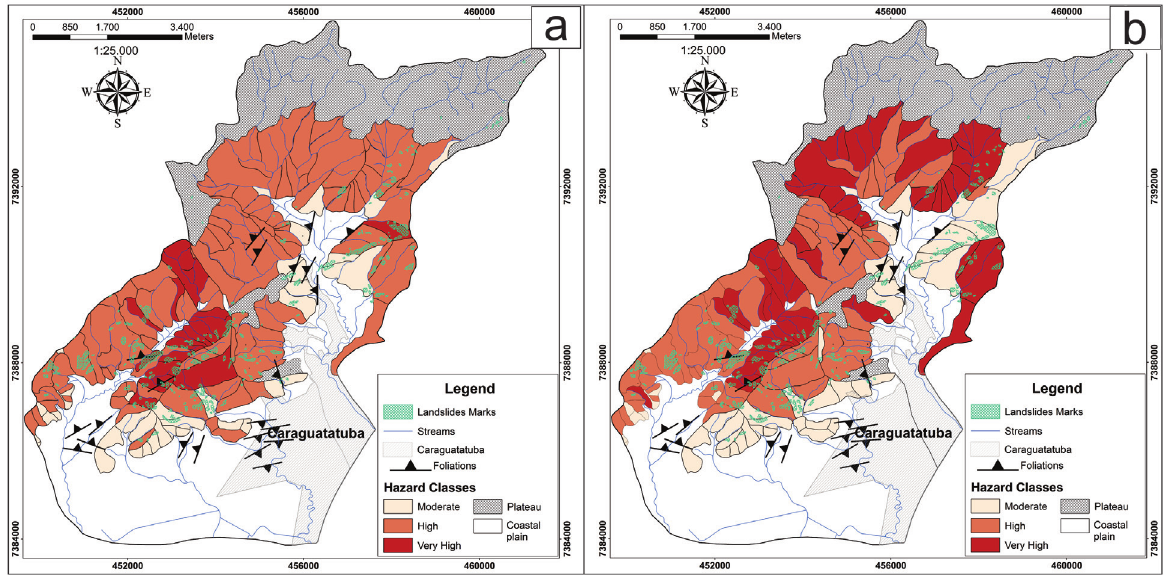
Figure 4 - Landslide Zonation Hazard map for the northeastern region of Caraguatatuba: ( a ) Planar Landslides and ( b ) Wedge